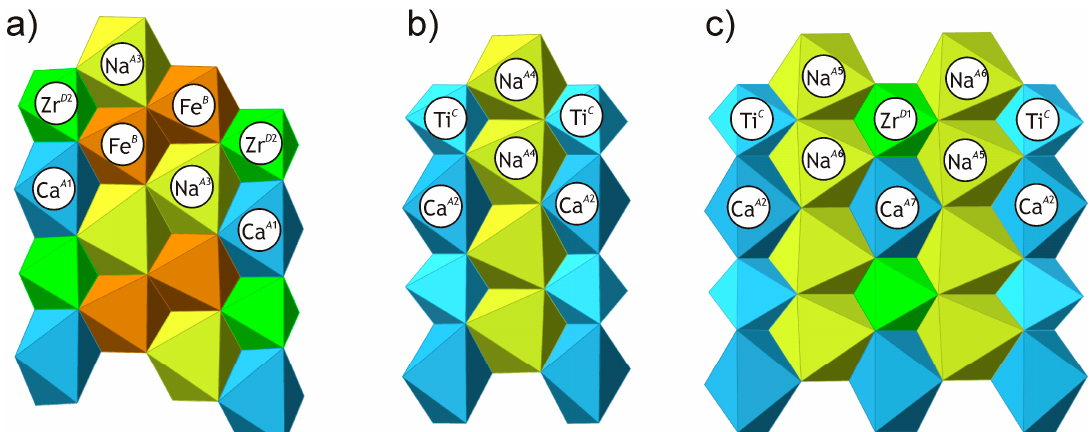
Figure 7. Three types of octahedral walls in the crystal structure of chirvinskyite: four- ( a ), three- ( b ) and five- ( c ) membered. Note that the three-membered and five-membered walls have one octahedral column in common. For the A sites, only the A –O bonds shorter than 2.6 Å are taken into account. Legend similar to Figure 6.